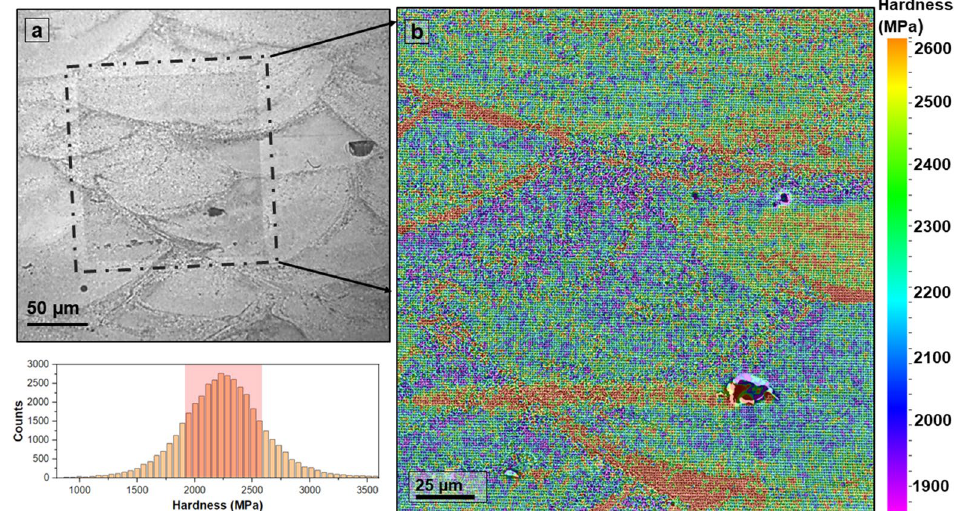
Figure 2. Nano-hardness map covering approximately six melt pools correlates well with the hierarchical and heterogeneous microstructure of the L-PBFAM processed Al–Ni–Ti–Zr alloy. ( a ) The optical micrograph confirms approximately six melt pools in the nanoindented region (dashed box), and ( b ) the hardness map captures the micromechanical variation within multiple melt pools. For statistical accuracy, the data within the one-sigma range was selected for mapping, and the selected region is highlighted in the adjoining